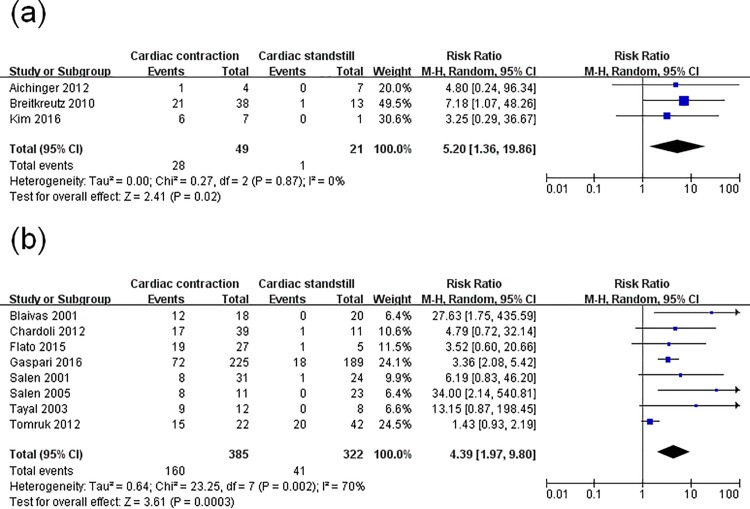
Forest plot of the subgroup analysis of cardiac activity on the restoration of spontaneous circulation.(a) studies whose ultrasound evaluation occurred pre-hospital; (b) studies whose ultrasound evaluation occurred in-hospital.